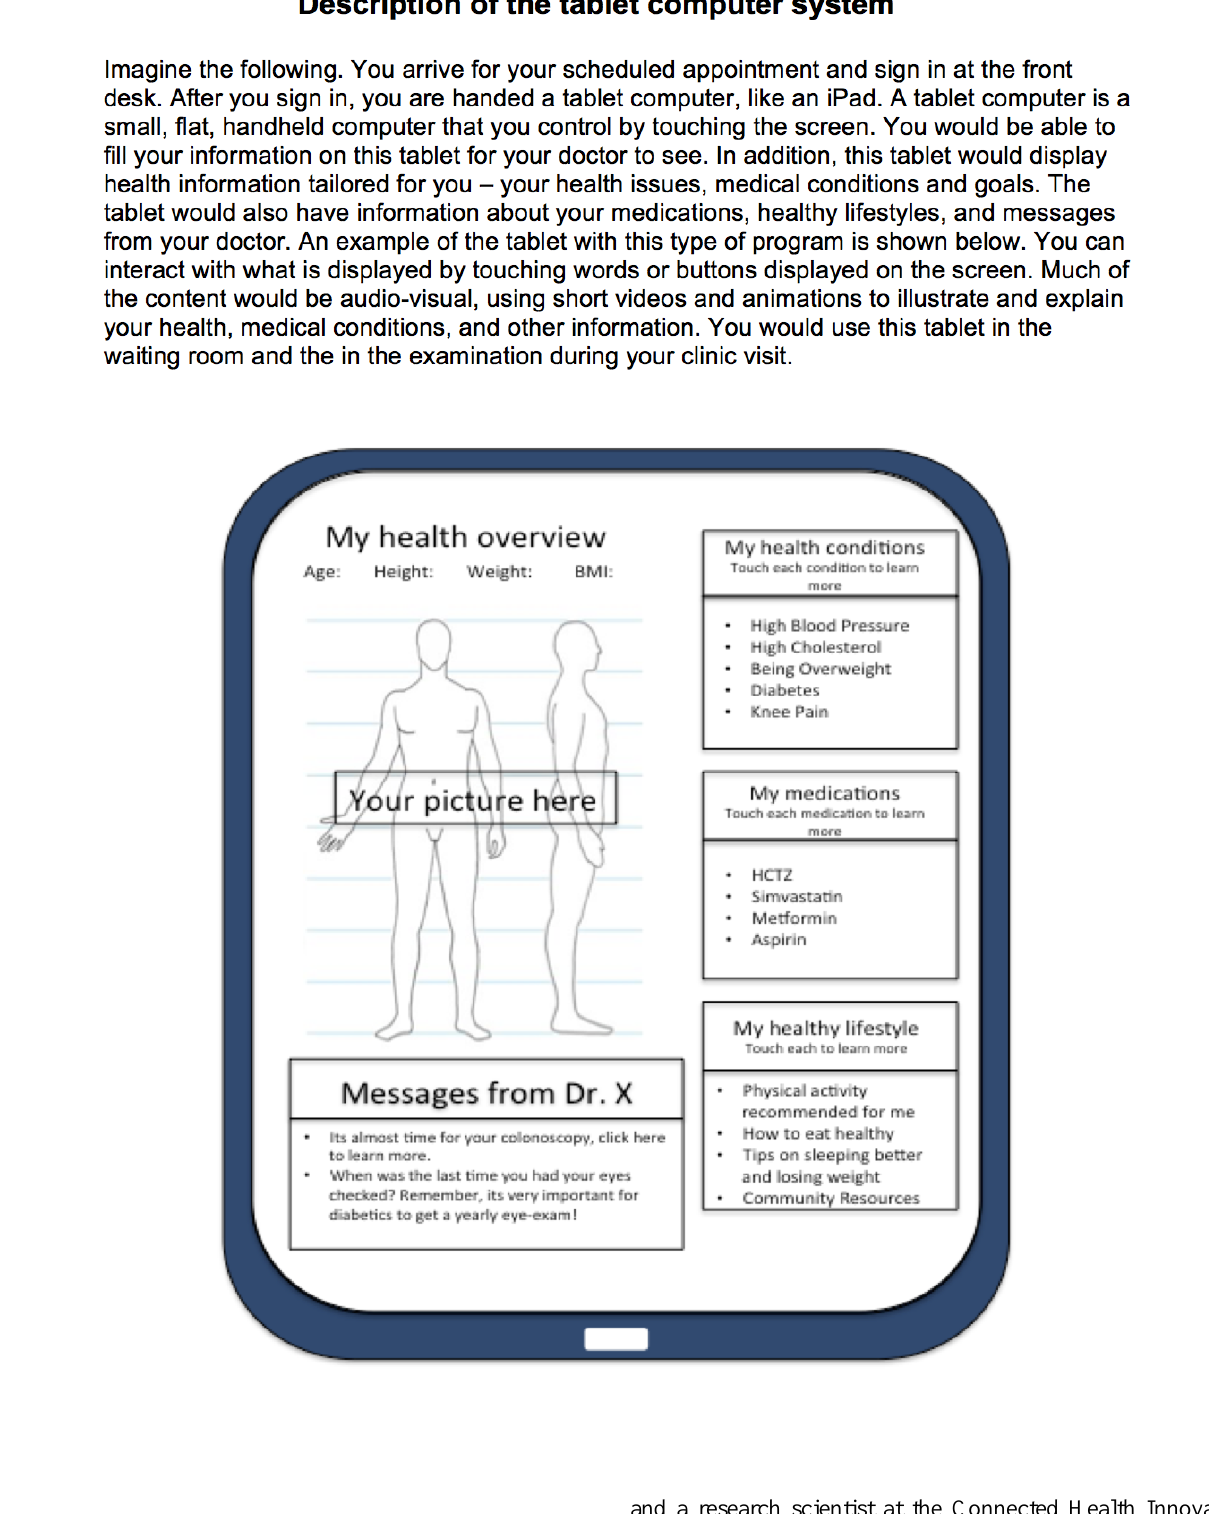
Figure 1. Diagram and description of tablet-based health information exchange system presented to